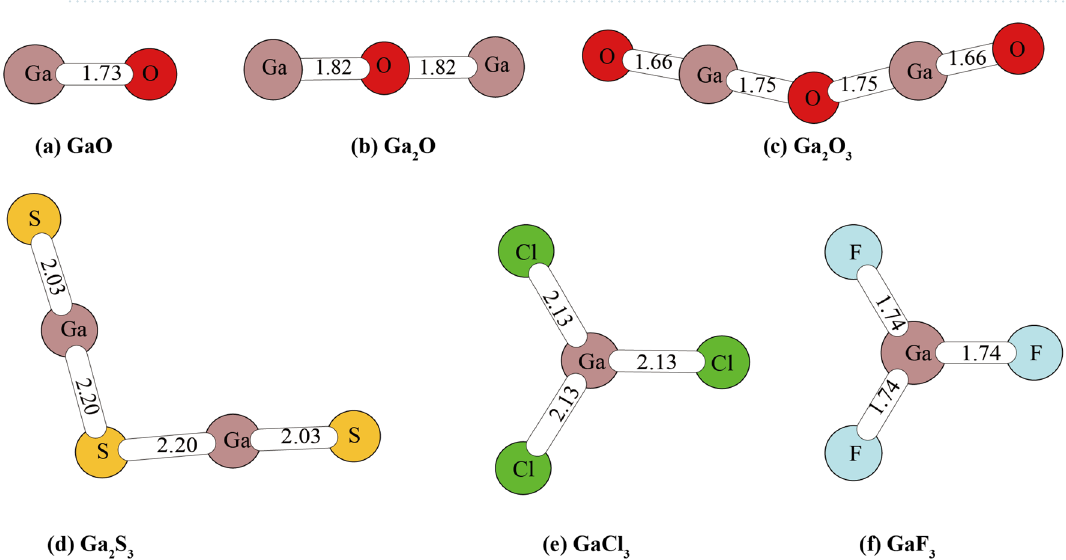
Figure 3. The structures of Ga-bearing gas phases. The numbers in this figure stand for bond lengths of different Ga-N bonds which N represents atoms O, S, Cl and